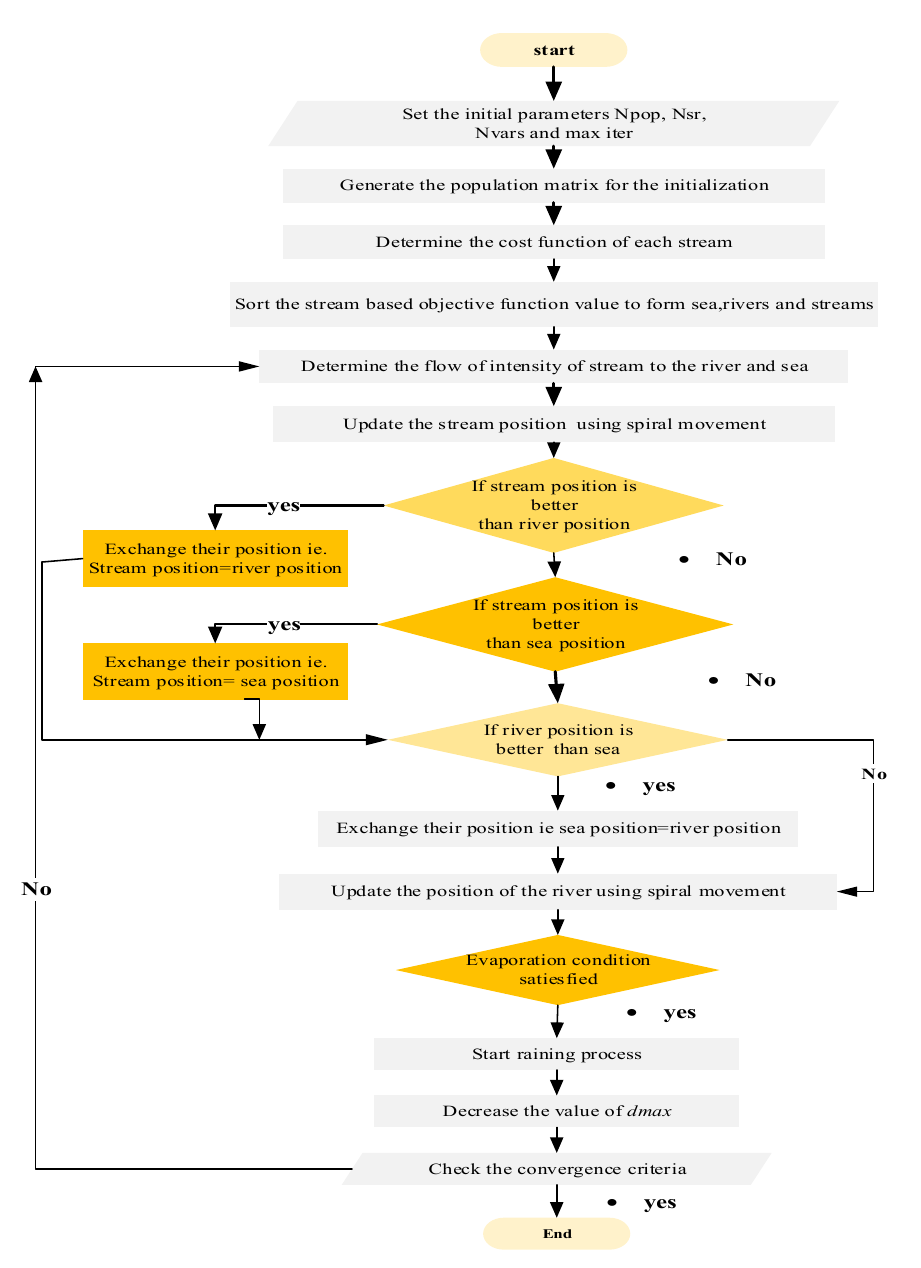
Figure 2. Hybrid WCMFO algorithm flowchart [15].